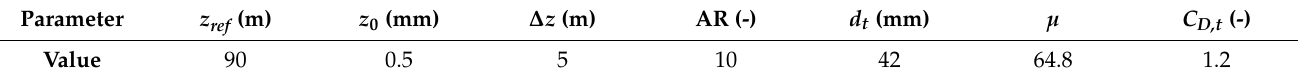
Table 2. The fixed input parameters adopted for the wind profile, kite sail and tether.